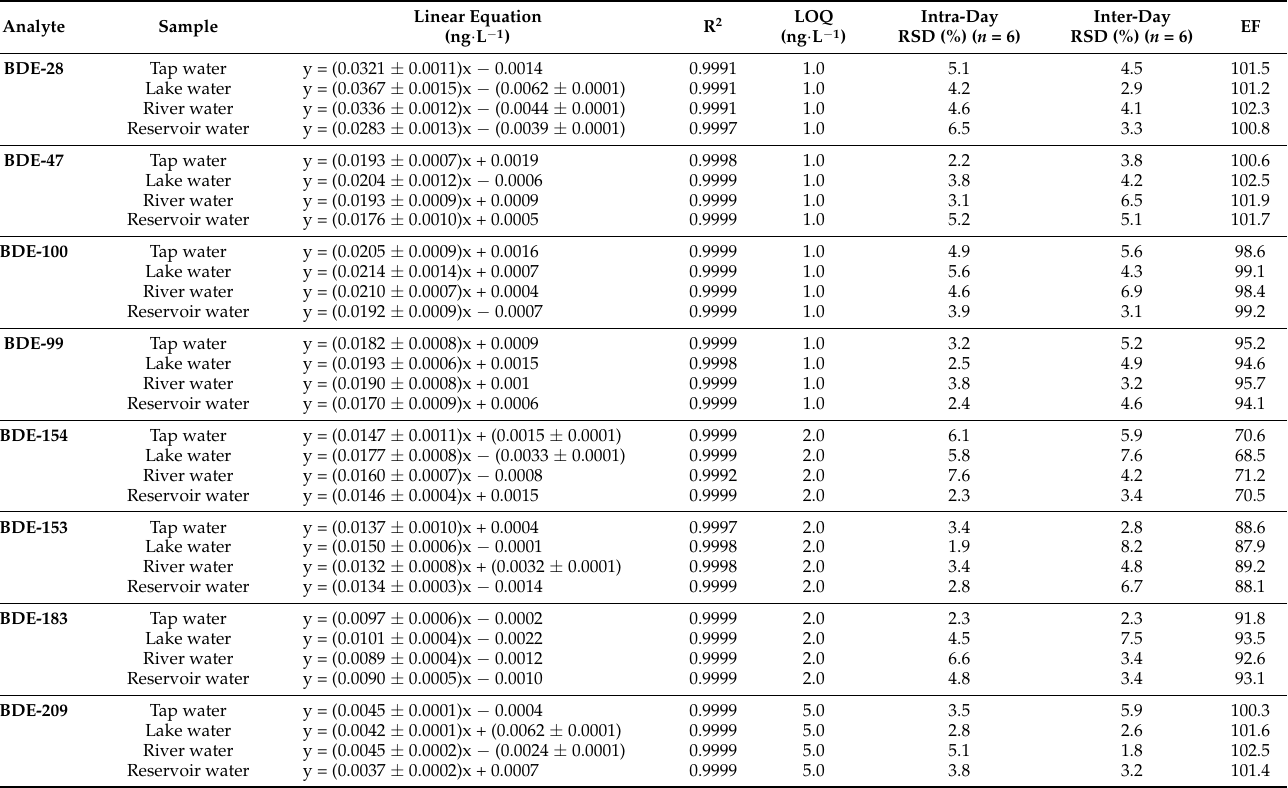
Table 1. Analytical Performance of EA-DLLME-SAP Coupled with GC-MS-MS